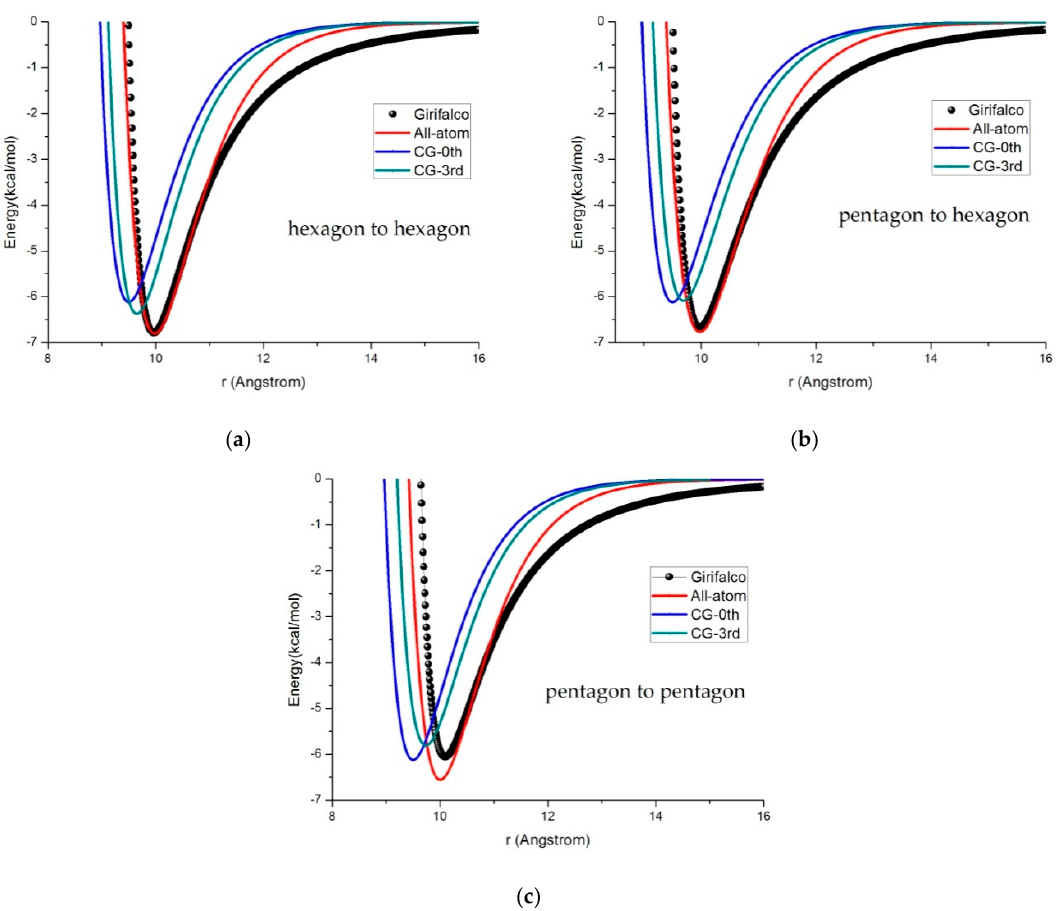
Figure 4. Comparison of the fitting curves (Girifalco potential, Morse potential with the all-atom model, 0th CG, and the 3rd CG model). ( a ) Hexagonal face-to-hexagonal face, ( b ) hexagonal face-to-pentagonal face and ( c ) pentagonal face-to-pentagonal face configurations.